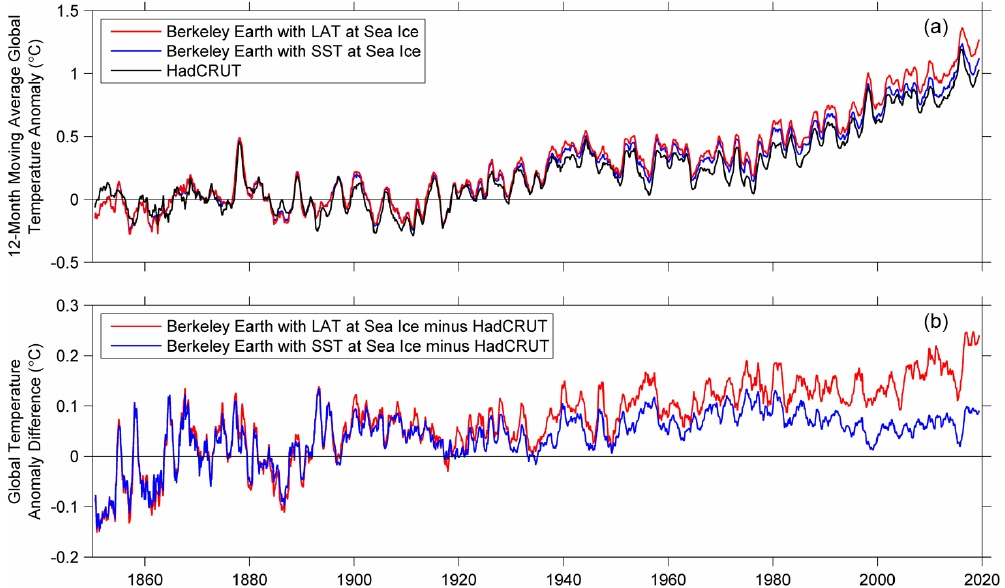
Figure 5. (a) Two variants of the Berkeley Earth global surface temperature product estimating temperatures under sea ice based on SSTs (red) or proximate air temperature measurements (blue), as well as the HadCRUT temperature series for comparison. (b) The same two versions of the Berkeley Earth data set with the HadCRUT time series